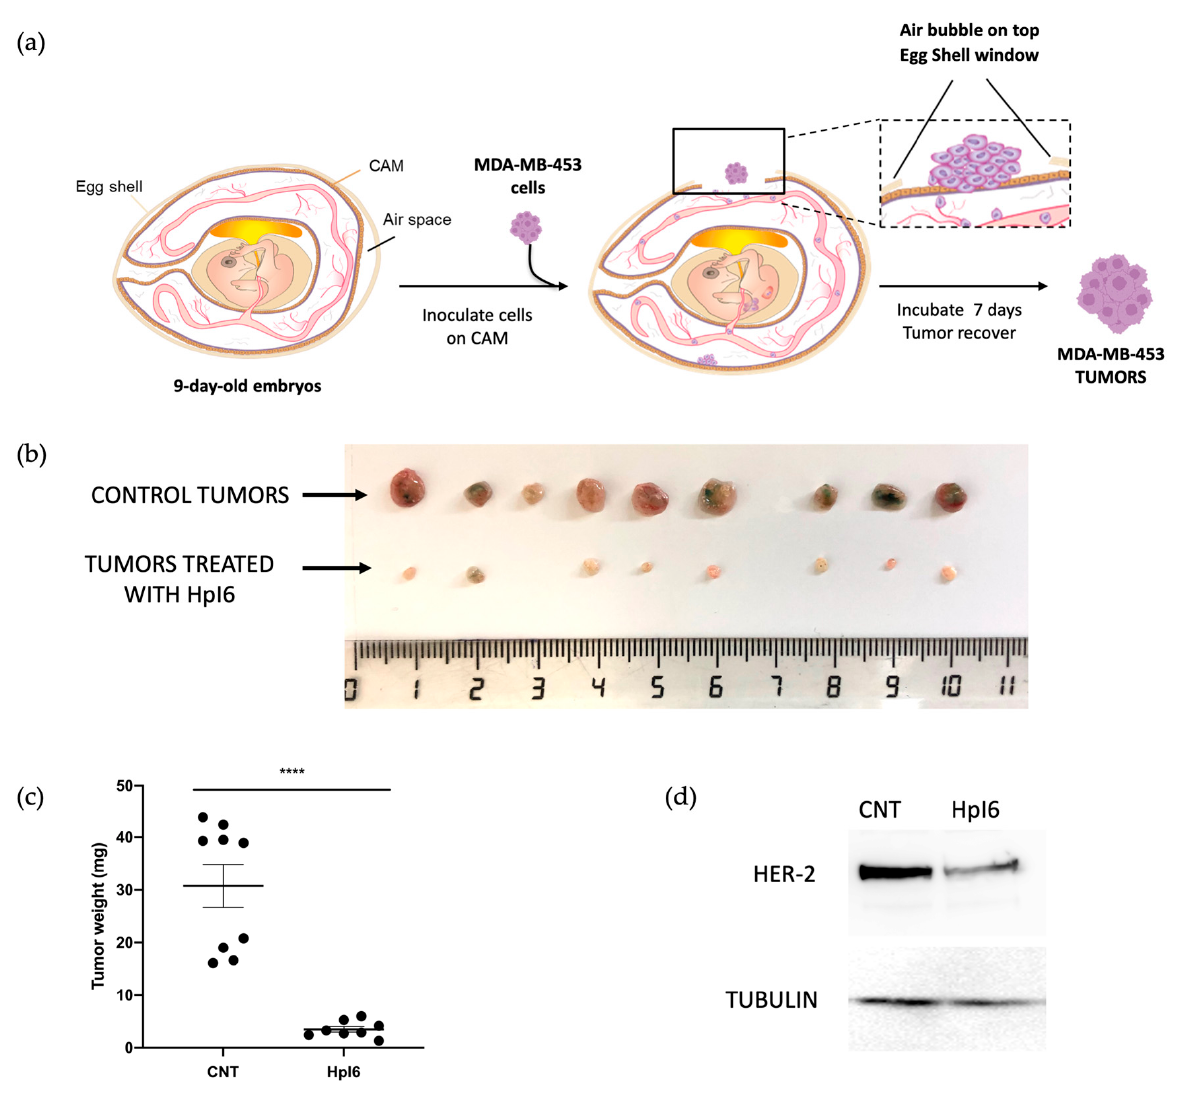
Figure 5. In vivo effects of HpI6. A sample of 330,000 MDA-MB-453 cells/well was seeded in 6-well dishes and transfected the following day with 400 nM of HpI6. Forty-eight hours after transfection, cells were inoculated in the CAM of chicken embryonated eggs. One week later, tumors were extracted and weighed. ( a ) Main steps in the CAM assay since the inoculation of MDA-MB-453 cells in the chick chorioallantoic membrane until the obtention of tumors. ( b ) The size of the control tumors (upper row) and those derived from cells transfected with HpI6 (lower row) is shown. ( c ) Distribution of tumor weight between control and transfected samples. ( d ) Representative blots of HER-2 levels determined by Western blot in total protein extracts prepared from pools of control ( n = 9) and transfected tumors ( n = 8). The signal corresponding to tubulin was used to normalize the results. Statistical significance was determined using an unpaired t -test (**** p < 0.0001). To assay the in vivo effect of the combinations of both PPRHs with trastuzumab, we chose a concentration of PPRHs of 300 nM and 100 µg/mL of TZ. As shown in Figure 6